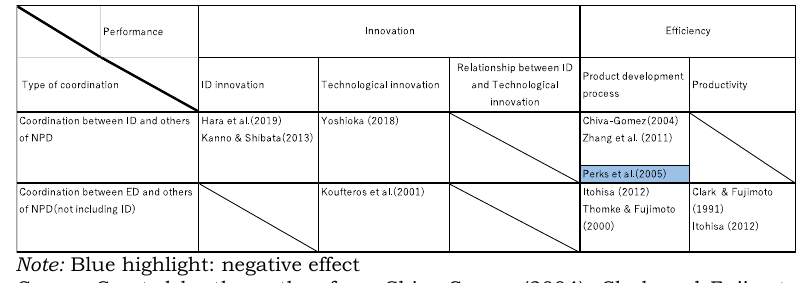
Table 1. Relationship between coordination and